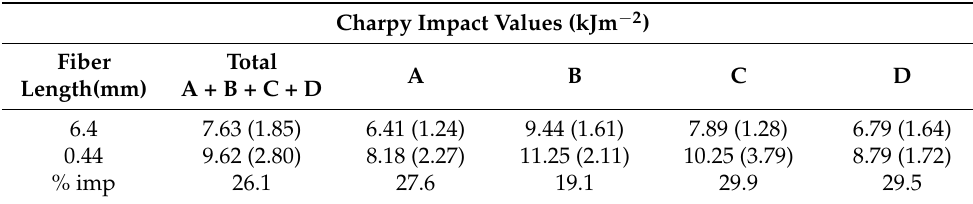
Table 5. Average Charpy impact values, a uc , and standard deviations for all texture angles, θ t cumulative (56 sample data set), and for each solidification texture angle sub-quadrant, A, B, C, and D. Standard deviations are in brackets.